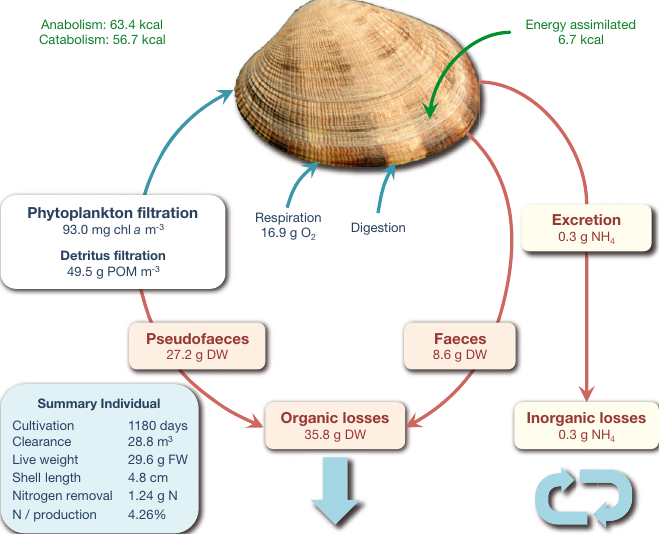
Fig. 7. WinShell mass balance results for an individual Manila clam over a full growth cycle at Chuckanut Shellfish farm. DW (FW): dry (fresh) weight; POM: particulate organic